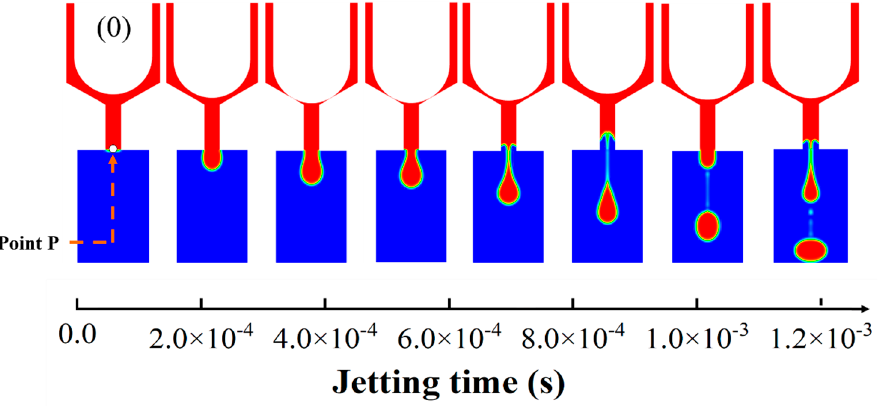
Figure 3. Evolution of droplets with time.